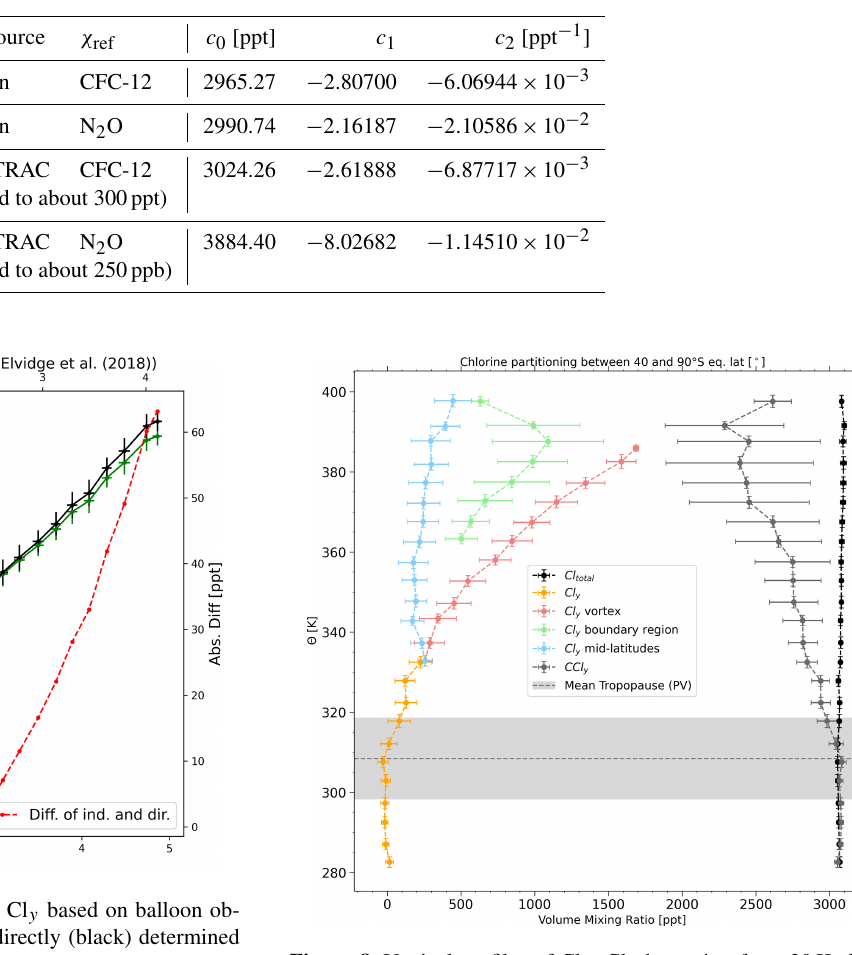
Figure 8. Vertical profiles of Cl y , Cl y by region from 20K above the local tropopause, CCl y , and Cl total averaged over 40–90 ◦ S equivalent latitude for all flights during SouthTRAC. The data are displayed as a function of potential temperature. Vertical and hori- zontal error bars denote 1 σ variability. The dashed line shows the averaged PV-based dynamical tropopause with the 1 σ variability as a shaded